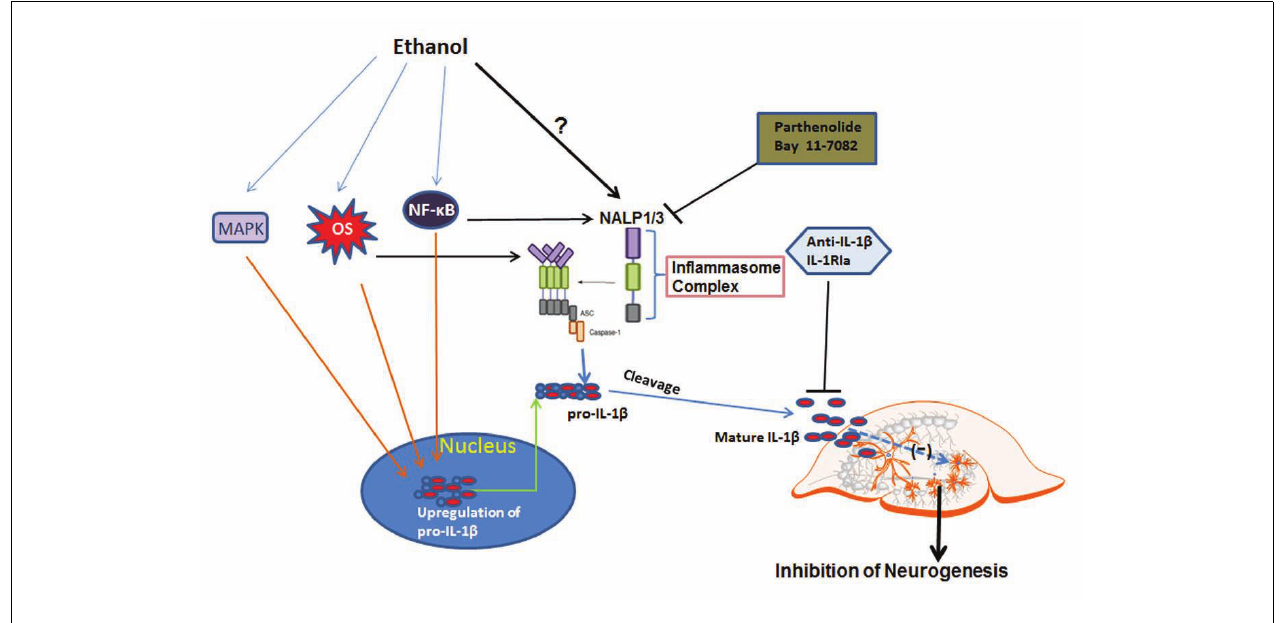
inflammasome protein NALP1 or NALP3.Two events associated with ethanol exposure lead to increased production of active form IL-1 β , contributing to inhibition of neurogenesis. Blockade of inflammasome activation with inhibitors to reduce IL-1 β release or directly neutralizing IL-1 β or blockade of IL-1 surface receptor can offer protection from ethanol-impaired